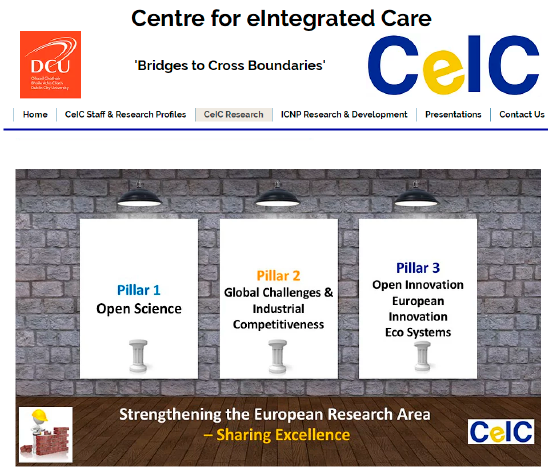
Figure 2. Screen shot of revised CeIC website.